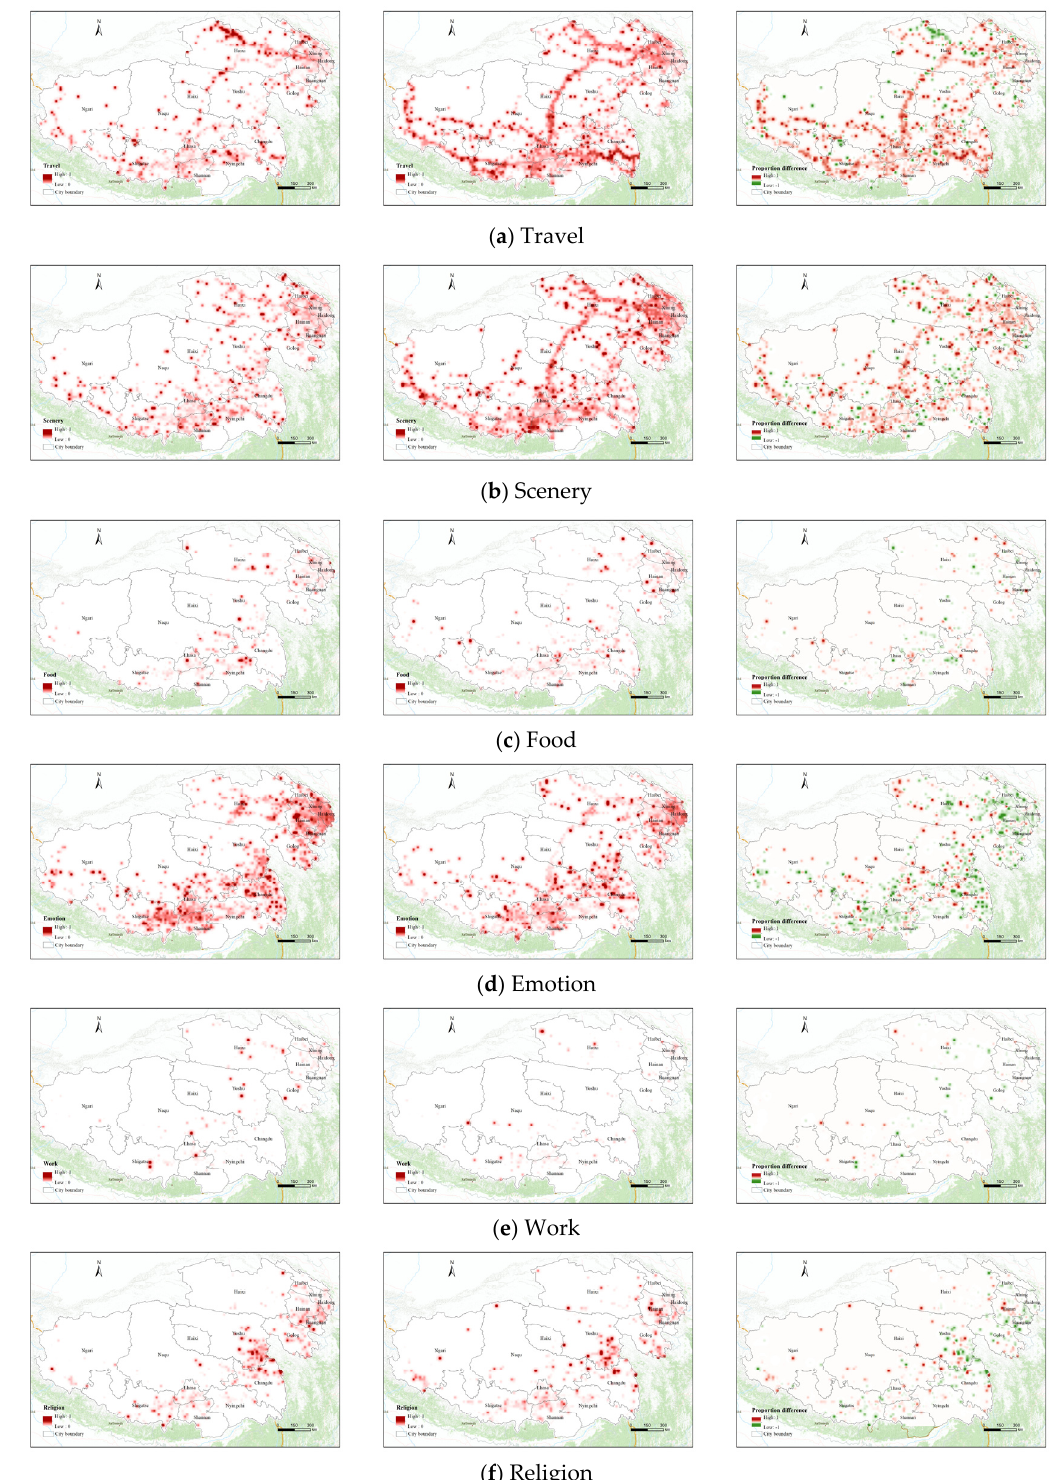
Figure 6. Spatial distributions of the perception strength of different semantics for residents (left column) and tourists (middle column). Right column shows the difference between the two, where the green color indicates that residents feel more strongly than tourists about a topic, and the red color indicates that tourists feel more strongly than residents about a topic.